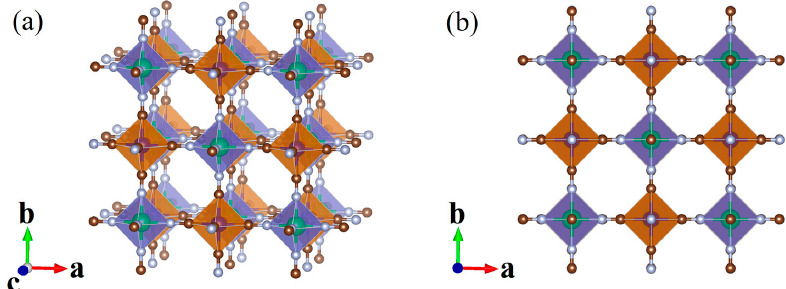
Figure 1. Crystal structure of GaFe(CN) 6 . ( a ) Side view; ( b ) top view. Table 1. Atomic occupied positions in GaFe(CN) 6